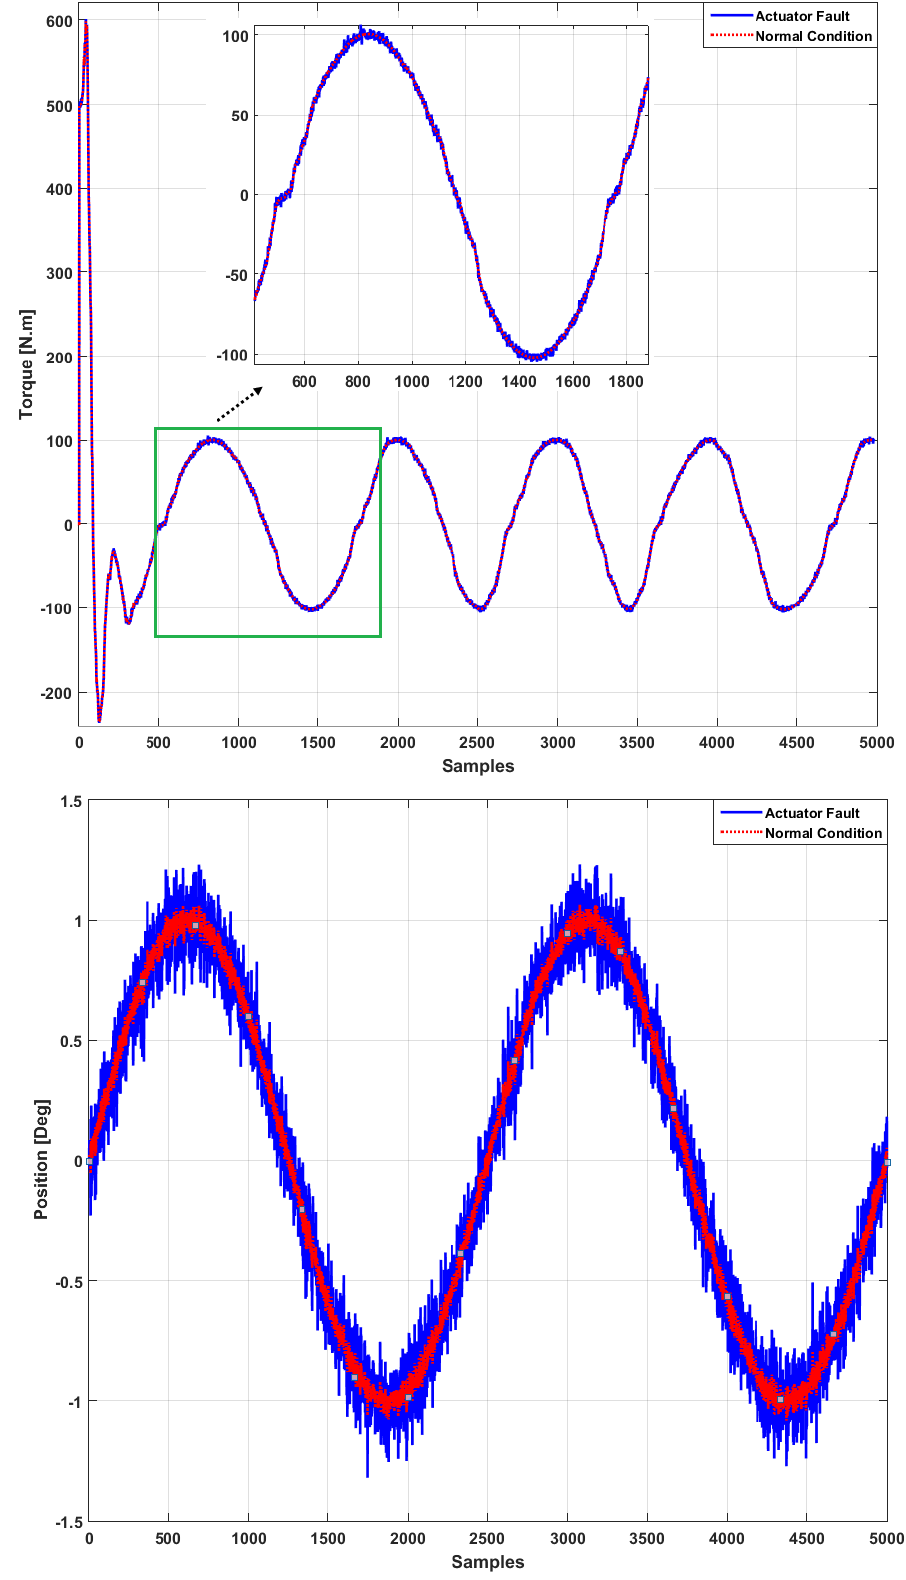
Figure 2. Torque and position of robot manipulator’s joint in normal and faulty actuator conditions. Algorithm 1. Support vector machined (SVM)-based adaptive neuro variable structure observer for fault diagnosis and fault-tolerant control of the robot manipulator.